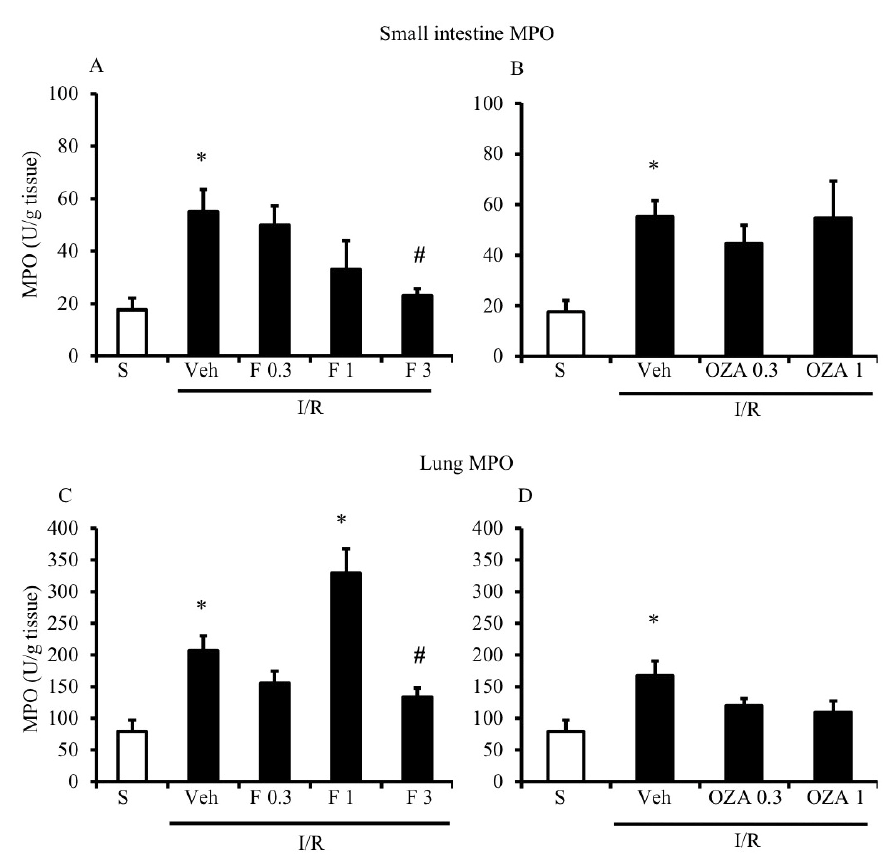
Figure 2. Effects of S1P modulators on ischemia/reperfusion (I/R)-induced neutrophil infiltration. Myeloperoxidase (MPO) activity in the small intestine ( A , B ) and lung ( C , D ) tissues excised from S mice (white bar) and from I/R mice administered with vehicle (Veh), FTY720 (F) 0.3–3 mg/kg i.v. ( A , C ) or ozanimod (OZA) 0.3, 1 mg/kg s.c. ( B , D ) ( n = 6–10 animals per group). * p < 0.05 vs. S mice; # p < 0.05 vs. Veh mice, one-way analysis of variance followed by Bonferroni’s post-test.